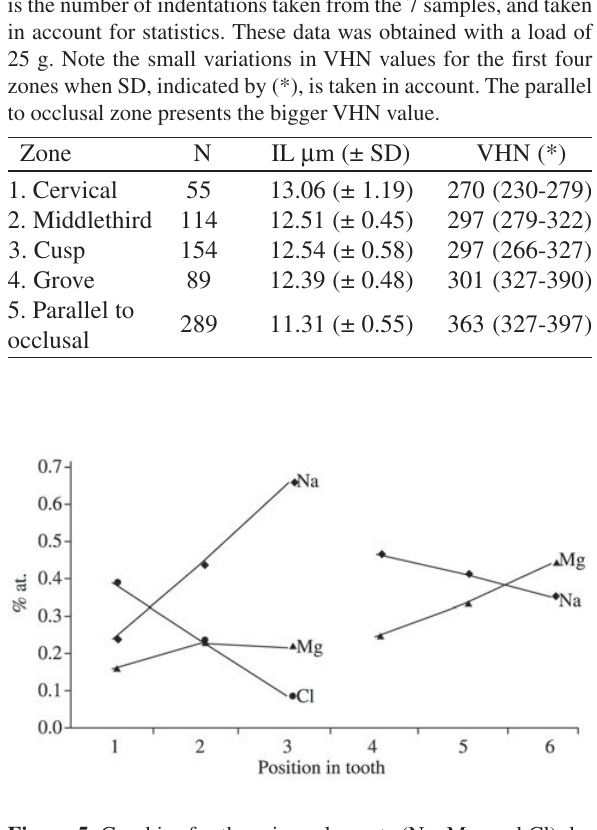
Figure 5. Graphics for the minor elements (Na, Mg, and Cl) de- tected in the human tooth from the outer enamel surface (number 1) to dentin inner layer (number 6) through the EDJ (num- bers 3 and 4). See Table 4. Note the increment of Na and the dec- rement of Cl from the outer enamel surface to the EDJ. In dentin Na shows a decrement after the EDJ, and Cl is not present. Mg concentration shows an increment from the outer enamel surface to the inner dentin surface. Each number represents a multiple of 40 µ m